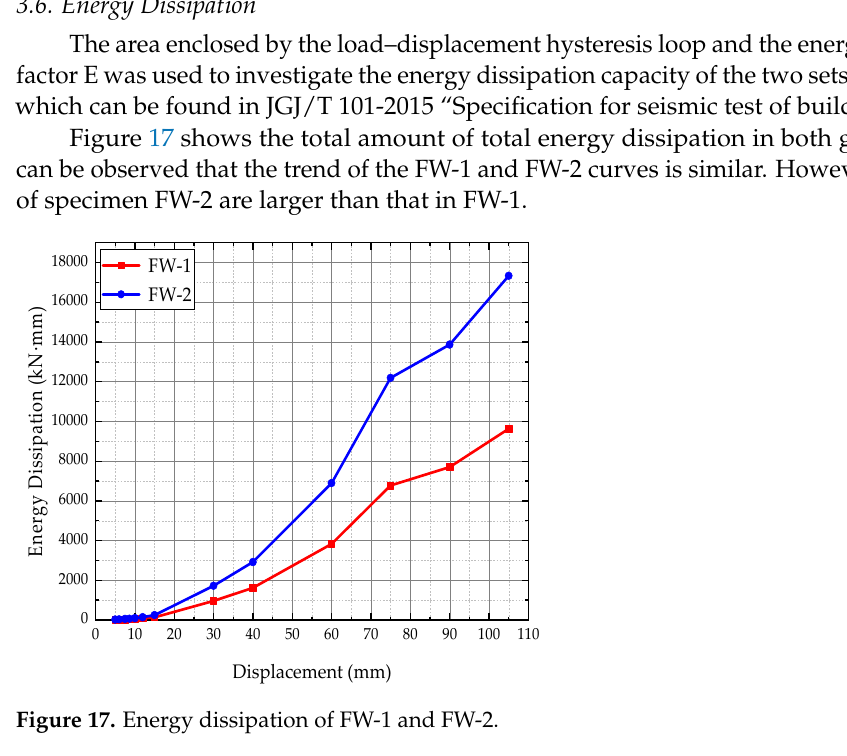
Figure 16. Stiffness degradation of FW-1 and FW-2.